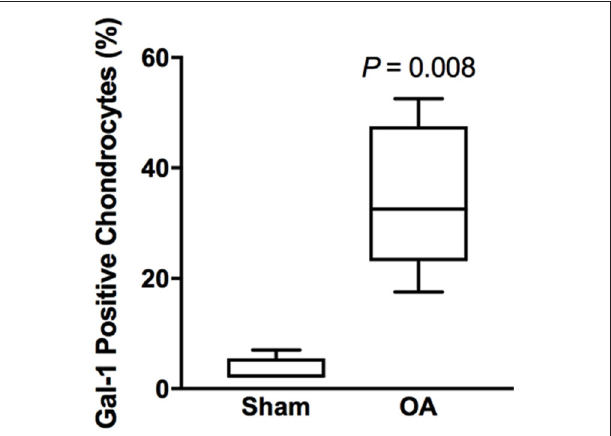
FIGURE 6 | Chondrocyte galectin-1 positive immunoreactivity over the entire thickness of articular cartilage in the equine carpal fragmentation experimental model 70 days post-injury ( n = 5). Data are presented as box-and-whiskers plots, where boxes represent the first and third quartiles, the lines within the boxes represent the median, and the lines outside the boxes represent the spread of galectin-1 scores. The P -value indicates the difference between injured (OA) and healthy (Sham) cartilage, produced by Wilcoxon matched-pairs signed rank test.